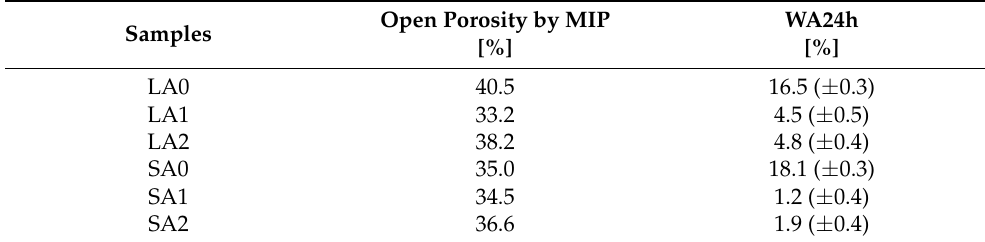
Table 4. Physical properties of the investigated mortars: open porosity (by MIP) and water absorption (WA24h) assessed after 180 days of curing in laboratory and the site situation. The values of WA24h correspond to the average ( ± standard